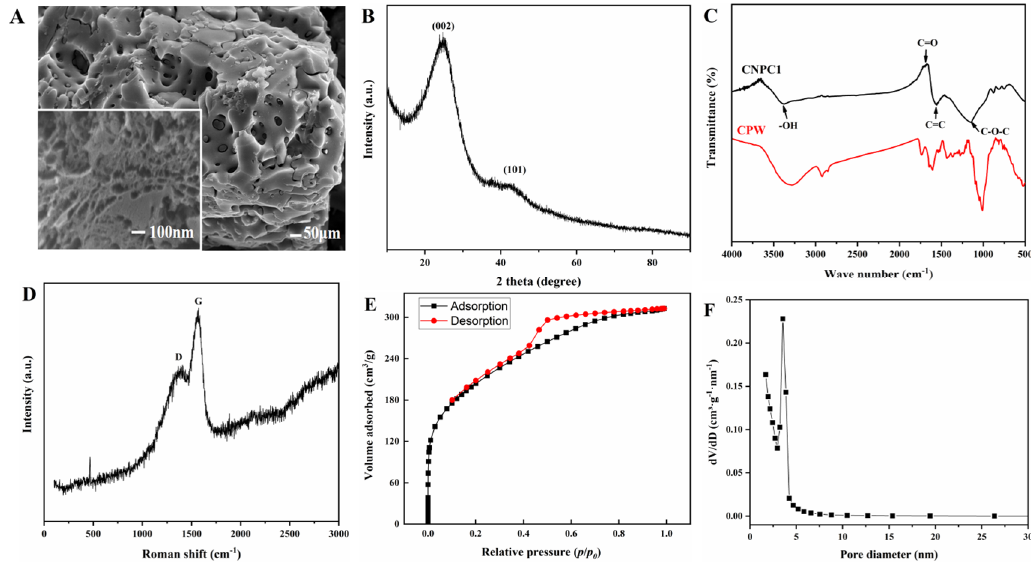
Figure 1. ( A ) SEM image, ( B ) XRD pattern, ( C ) FT–IR spectra, ( D ) Raman spectrum, ( E ) nitrogen adsorption isotherms, and ( F ) pore size distributions of citrus nano porous carbon.